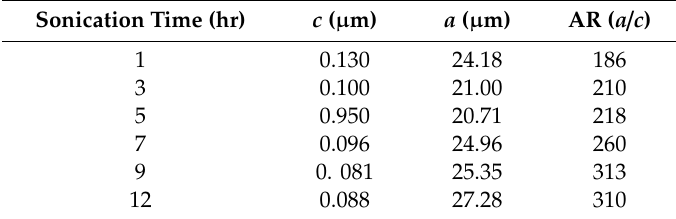
Table 6. a , c , AR values for sample M X3C3 ( d = 44 Å).